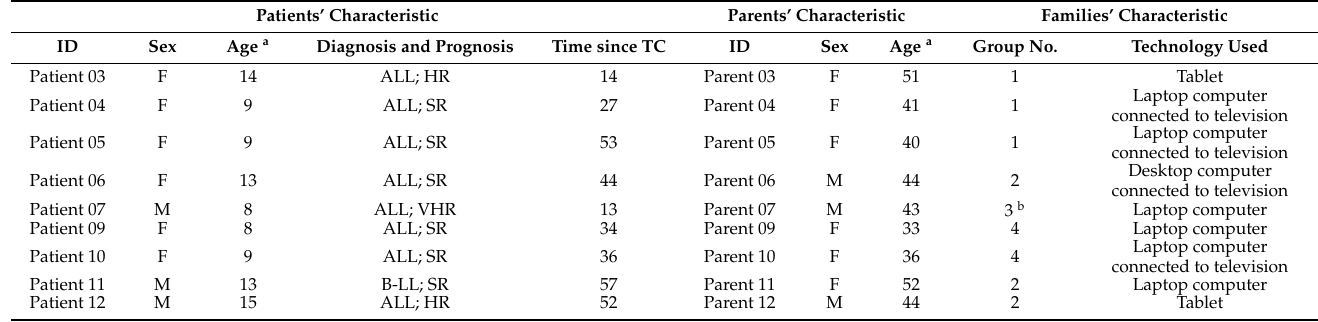
Table 1. Participant characteristics and technologies used for the program.